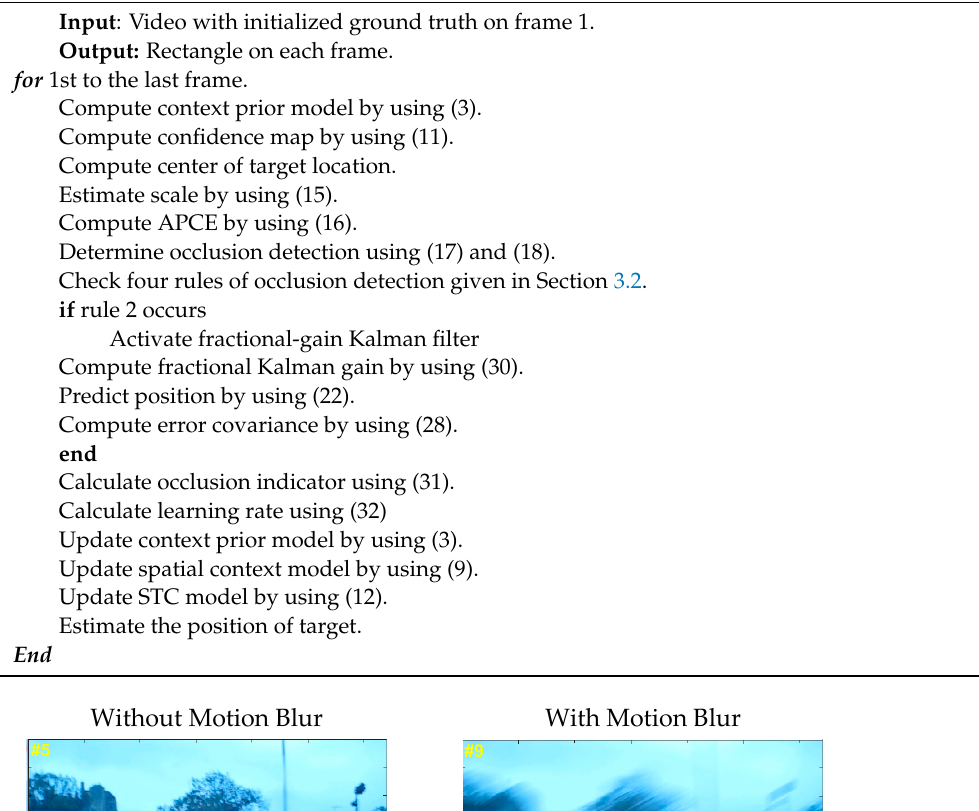
Algorithm 1: Proposed Tracking Method